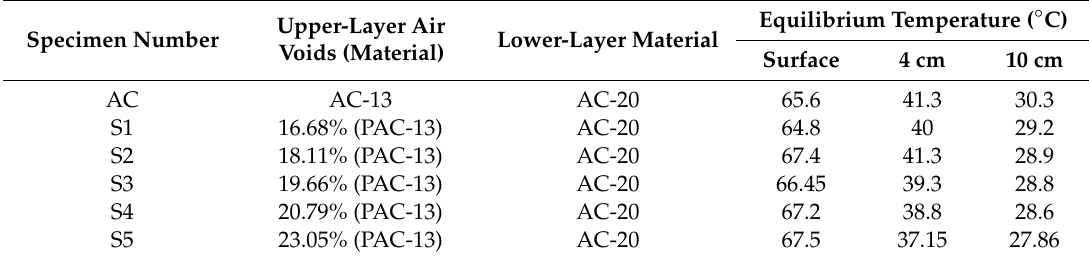
Table 3. Specimen equilibrium temperature.